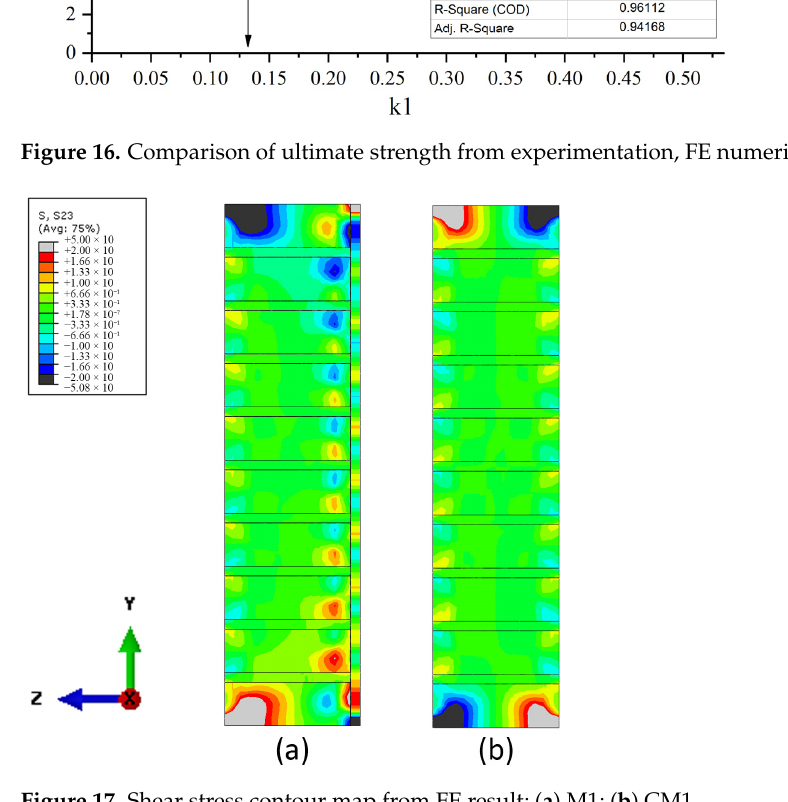
Figure 17. Shear stress contour map from FE result ; ( a ) M1; ( b ) CM1.